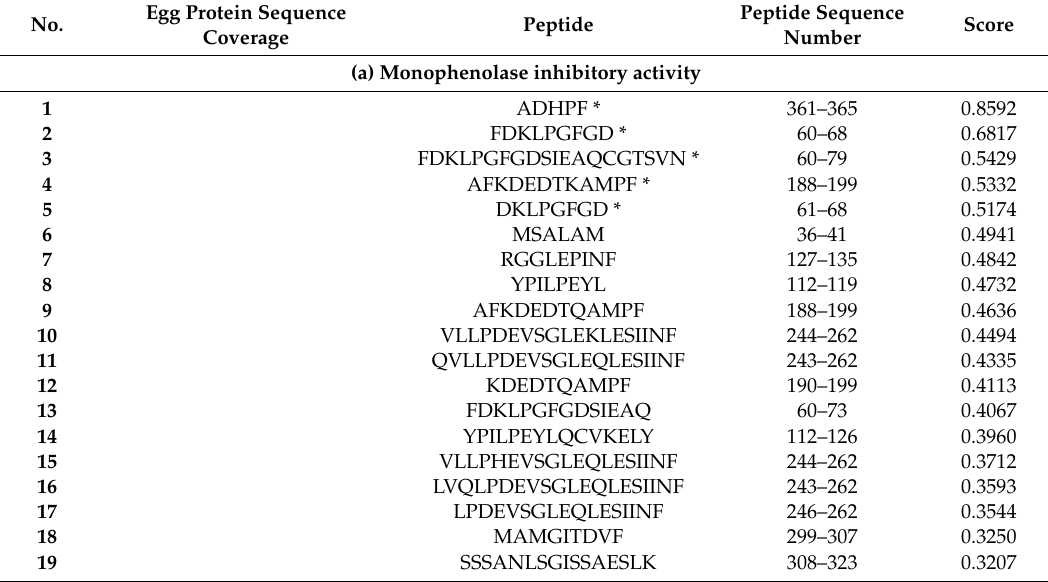
Table A1. List of egg white-derived peptides for ( a ) monophenolase and ( b ) diphenolase inhibitory activities with their corresponding PeptideRanker